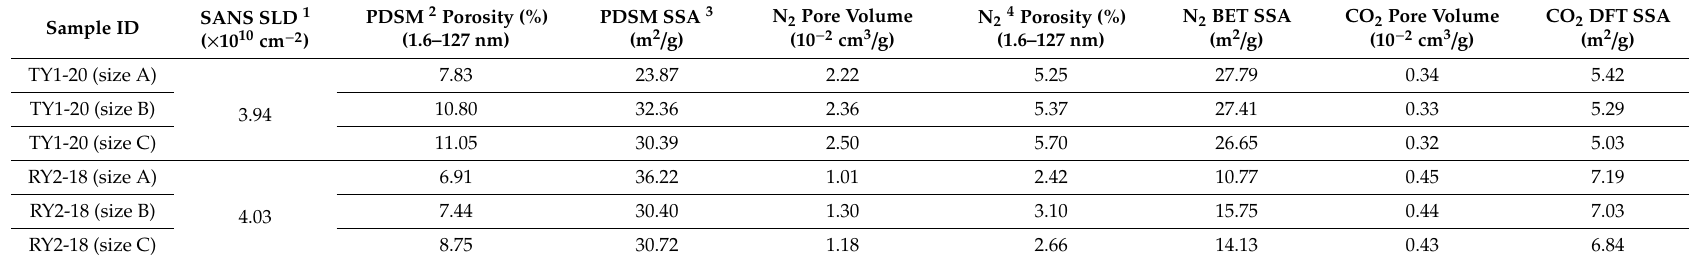
Table 2. Pore parameters of samples from SANS and gas (N 2 and CO 2 )